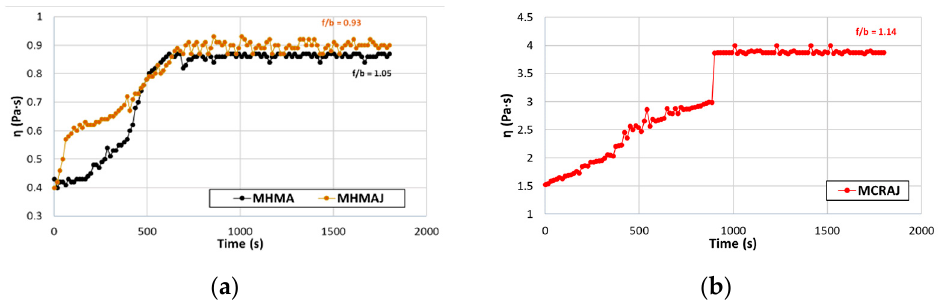
Figure 8. Viscosity variation by mixing time: ( a ) MHMA vs. MHMAJ and ( b ) MCRAJ.